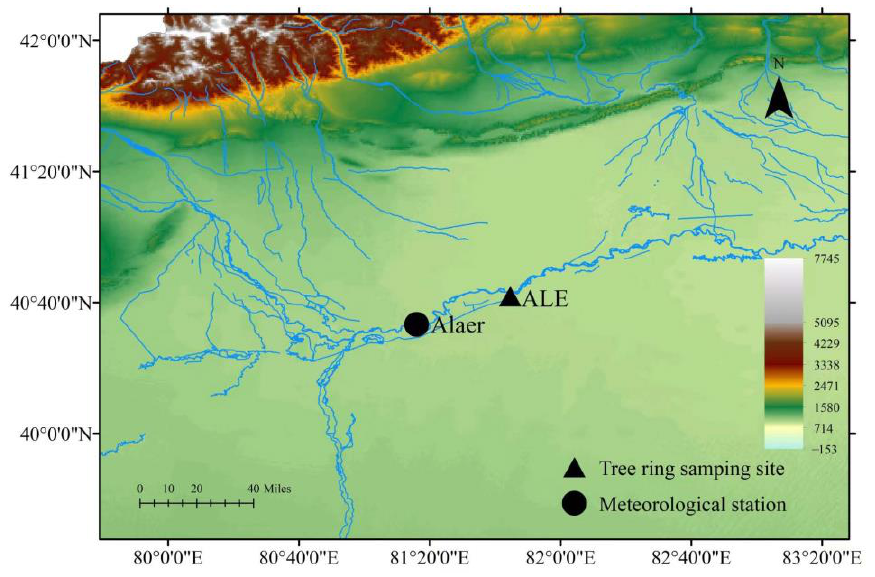
Figure 1. Map of the sampling (Alaer, ALE) site and nearby meteorological station in Alaer, Xinjiang, China.